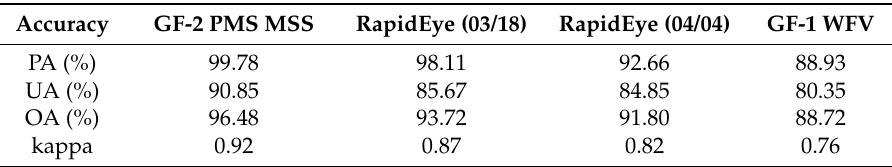
Figure 14. CSRA-derived oilseed rape maps using ( a ) GF-2 PMS MSS image on 18 March 2016; ( b ) RapidEye image on 18 March 2016; ( c ) RapidEye image on 4 April 2016; and ( d ) GF-2 WFV image on 28 March 2016 in part of Shayang County. ( e – g ), and ( h ) were the zoom image of the black rectangle in ( a – d ). Table 5. Accuracy assessment for the CSRA-derived oilseed rape maps of GF-2 PMS MSS, RapidEye, and GF-1 WFV images in part of Shayang